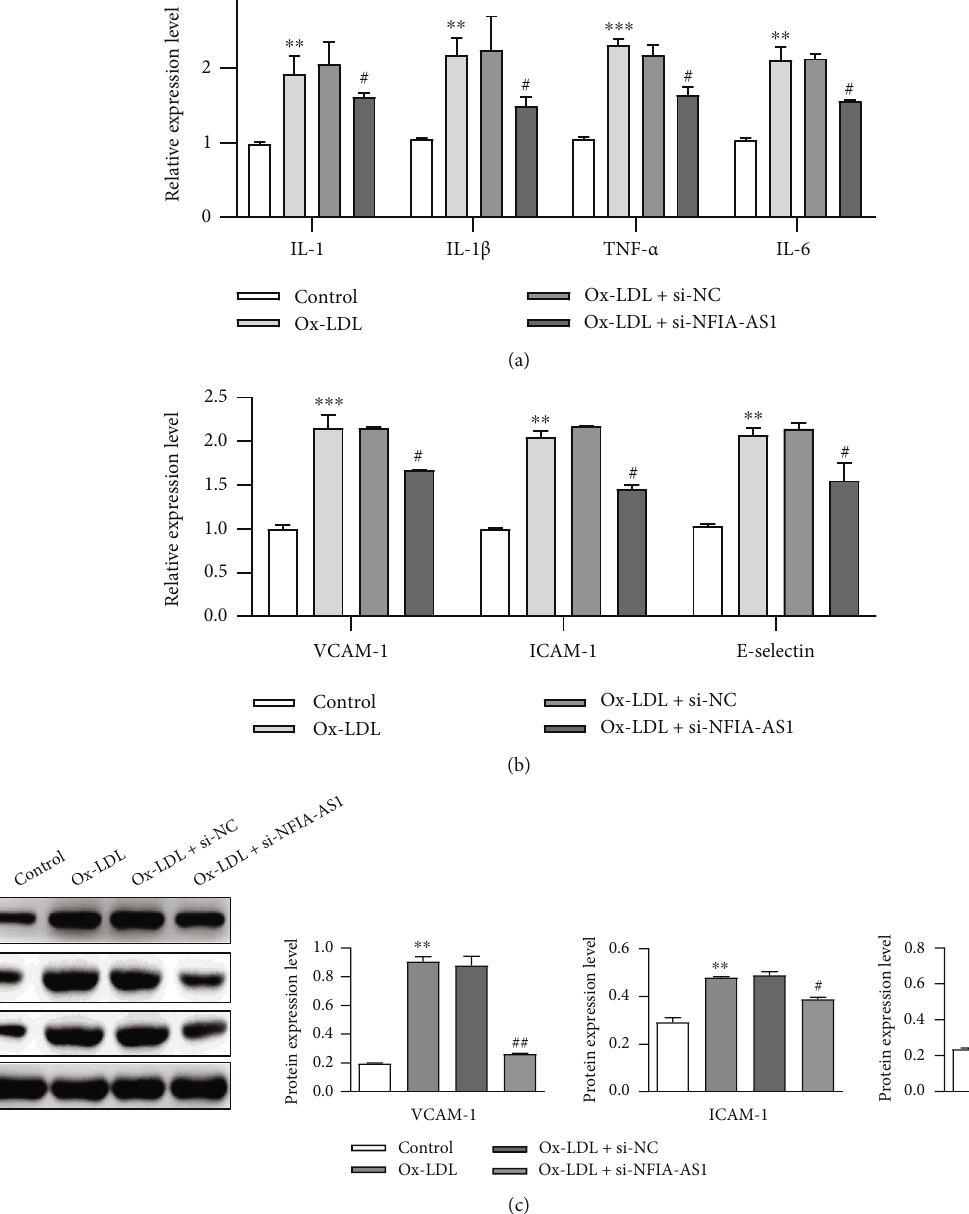
Figure 3: KD of NFIA-AS1 reduces in fl ammation in Ox-LDL-induced VSMCs. (a) The relative expression levels of in fl ammatory cytokines in VSMCs of control, Ox-LDL, Ox-LDL +si-NC, and Ox-LDL+ si-NFIA-AS1 groups were detected by qRT-PCR. (b) The mRNA expression of VCAM-1, ICAM-1, and E-selectin was detected by qRT-PCR. (c) The protein expression of VCAM-1, ICAM-1, and E-selectin was detected by western blot. ** P < 0 : 01 and *** P < 0 : 001 versus control group. # P < 0 : 05 and ## P < 0 : 01 versus Ox-LDL+si-NC